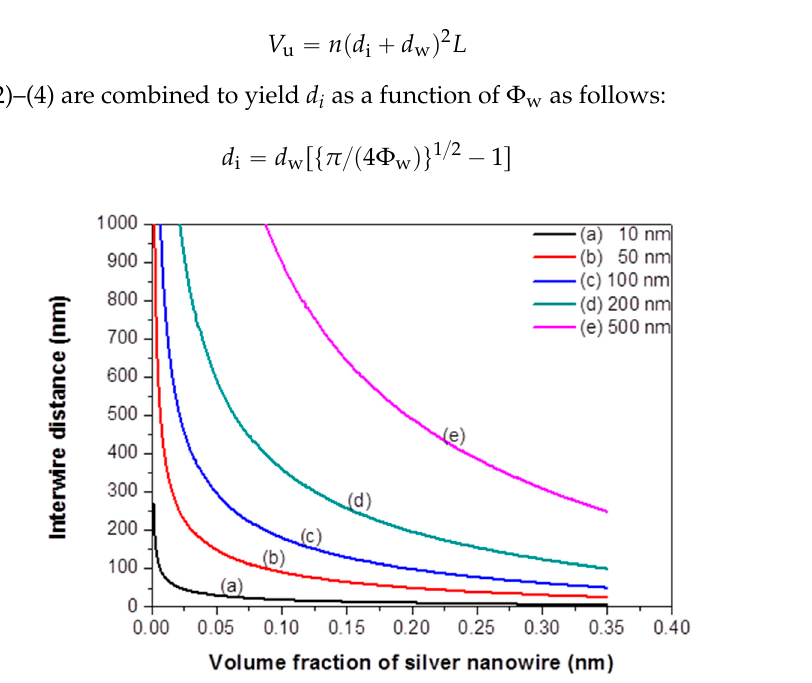
Figure 5. Interwire distances of AgNWs of different diameters: ( a ) 10 nm; ( b ) 50 nm; ( c ) 100 nm; ( d ) 200 nm; and ( e ) 500 nm.